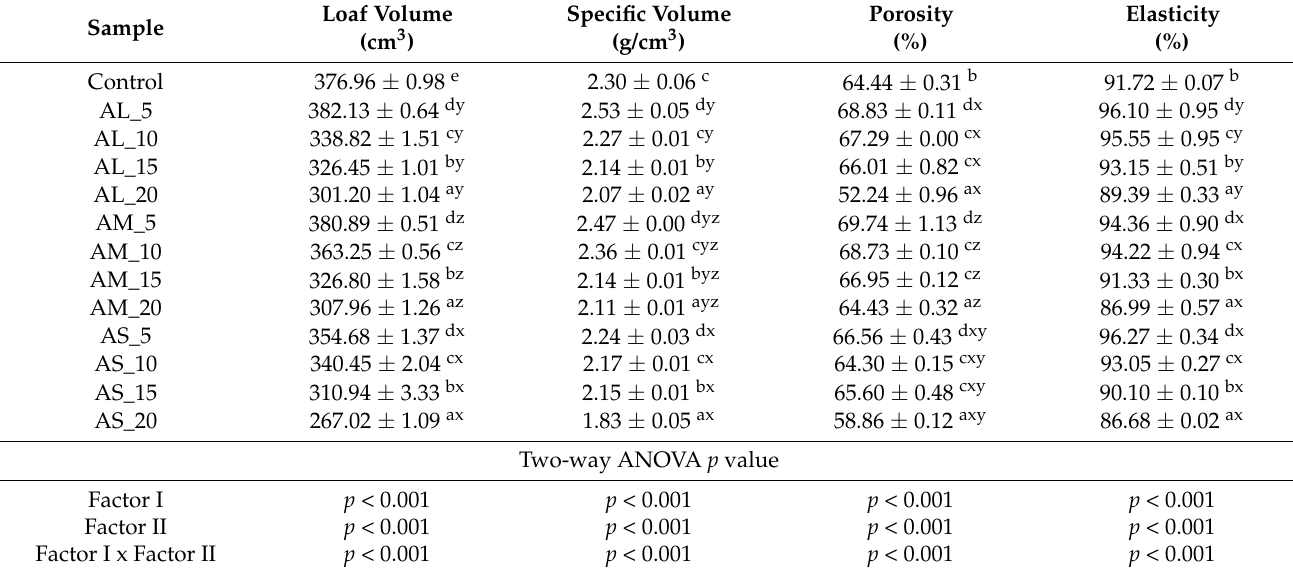
Table 4. Technological properties of bread as influenced by amaranth flour of large (AL), medium (AM), and small (AS) particle sizes added at 5%, 10%, 15%, and 20% compared with the